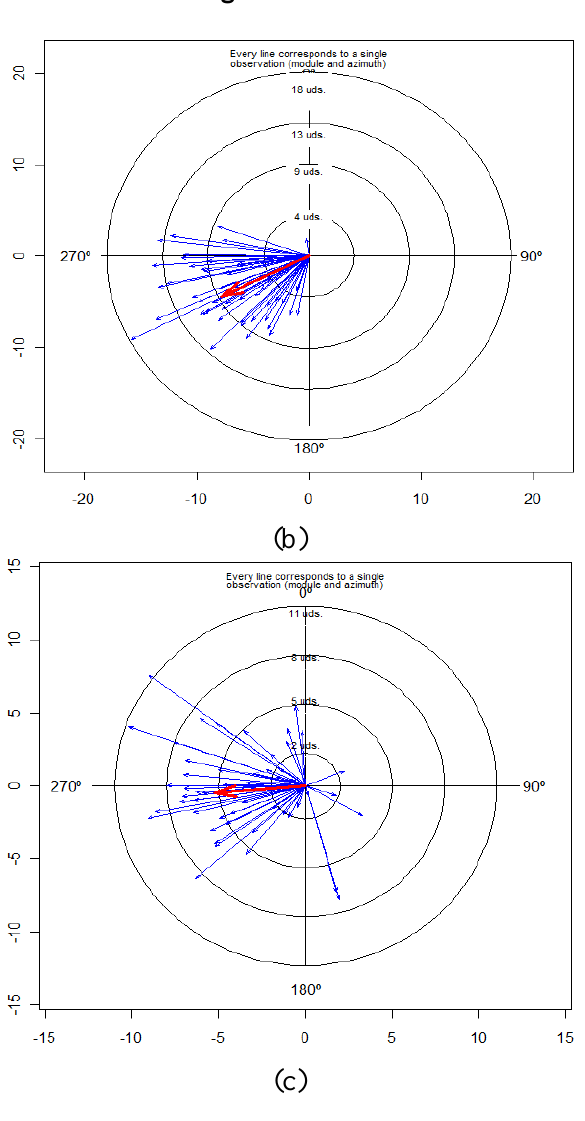
Figure 6. Map of vectors in the ZX wall-plane, 2D circular graphics analysis for each point in the wall (made with